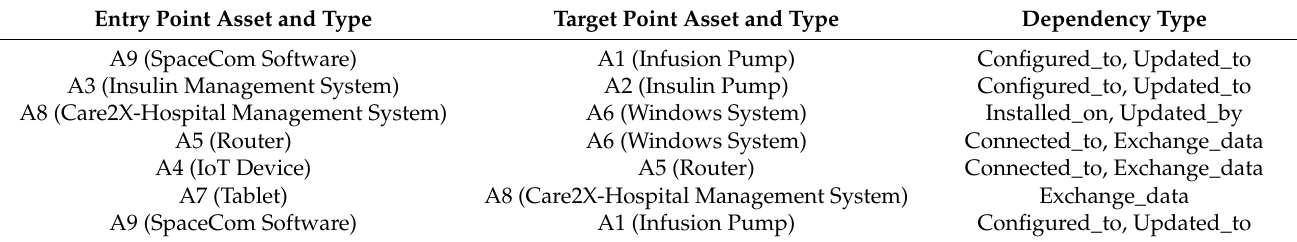
Table 4. Asset dependency.